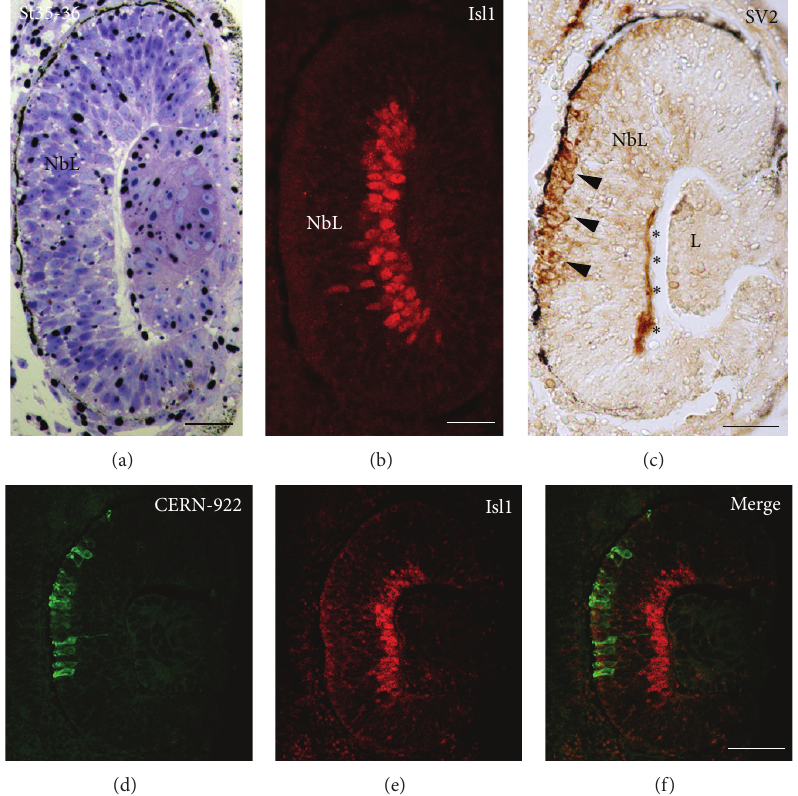
Figure 4: Morphological features and expression patterns of Isl1 and other cell differentiation markers in the St35/36 Xenopus laevis retina. (a) Toluidineblue-stainedtransverseretinalresinsectionsshowedthatneuralretinaremainedundifferentiatedduringthisstage.(b)Althoughno plexiform layers were observed, many Isl1-positive nuclei were mainly located near the inner surface of the neuroretina. (c) Immunoreactive ganglion cell axons for SV2 were observed in the vitreal surface of the retina (asterisks). Furthermore, immunoreactivity was also detected near the scleral surface of the undifferentiated retina (arrowheads). (d)–(f) CERN-922 antibody revealed that sparse photoreceptors were differentiating by this stage in the scleral surface of the central nonlayered retina ((d), (F)). L: lens; NbL: neuroblastic layer. Scale bars: 50 𝜇